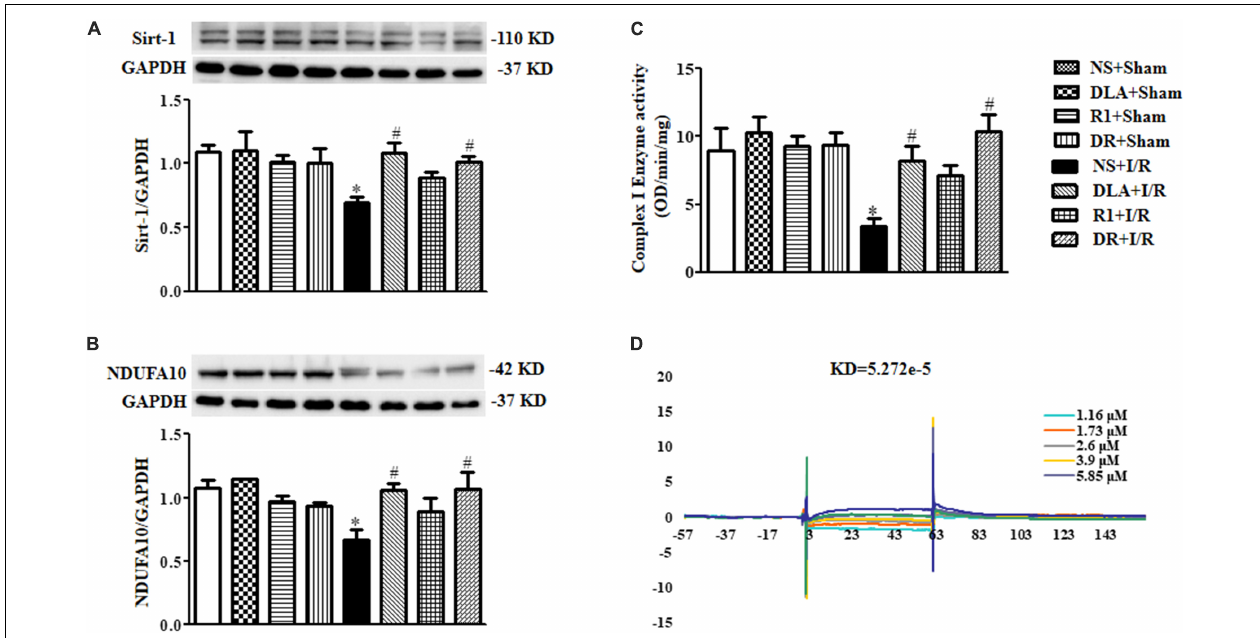
FIGURE 8 | 3,4-dihydroxyl-phenyl lactic acid and DR, but not R1, bind to and activate Sirtuin1 (Sirt-1). (A) Displayed are examples of Western blot bands of Sirt-1 in various groups, with quantitative results shown below. Quantitative results for Sirt-1 band intensities were normalized to GAPDH (n = 6). (B) Representative Western blot bands of NADH dehydrogenase (ubiquinone) 1 alpha subcomplex 10 (NDUFA10) in various groups with quantitative results shown below. Quantitative results for NDUFA10 band intensities were normalized to GAPDH (n = 6). (C) Complex I activity determined based on the slope of increase in OD at 450 nm in all groups (n = 6). Data are expressed as means ± SEM (n = 6). * p < 0.05 vs. NS + Sham group; # p < 0.05 vs. NS + I/R group. (D) Examples of sensorgrams obtained for R1 at 1.16, 1.73, 2.6, 3.9, and 5.85 µ M (curves from bottom to top) using surface plasmon resonance (SPR).